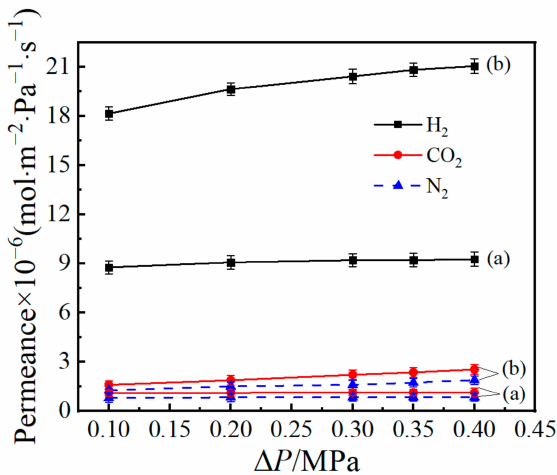
Figure 8. Influence of pressure difference on the gases’ (H 2 , CO 2 , and N 2 ) permeances for supported ( a ) MSiO 2 membrane and ( b ) supported Co/MSiO 2 membrane with n Co = 0.08 at 200 ◦